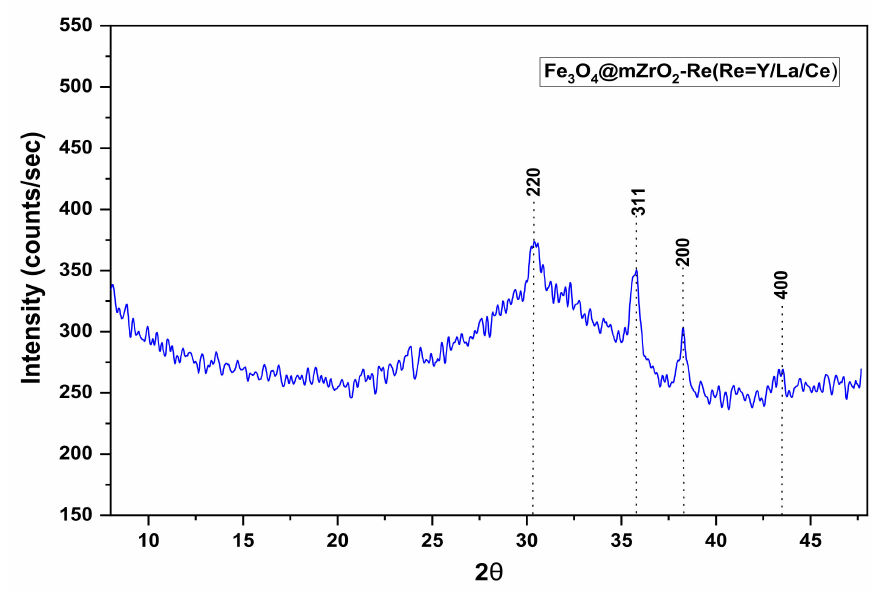
Figure 7. XRD spectrum of Fe 3 O 4 @mZrO 2 -Re (Re =